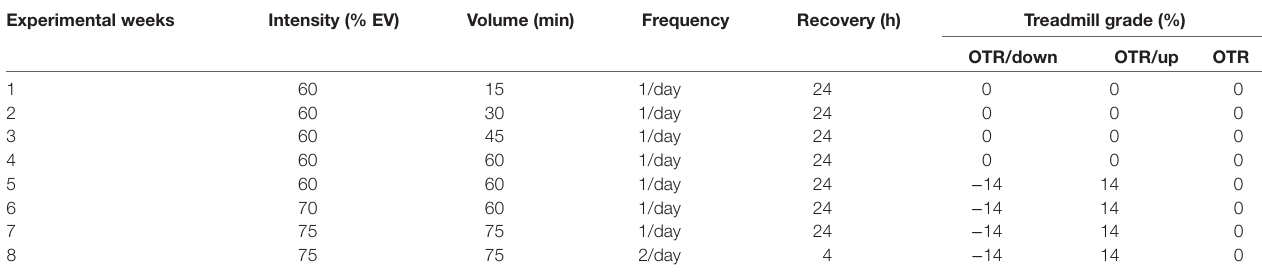
Table 2 | Characteristics of the running overtraining (OT) protocols performed in downhill, uphill and without inclination. experimental